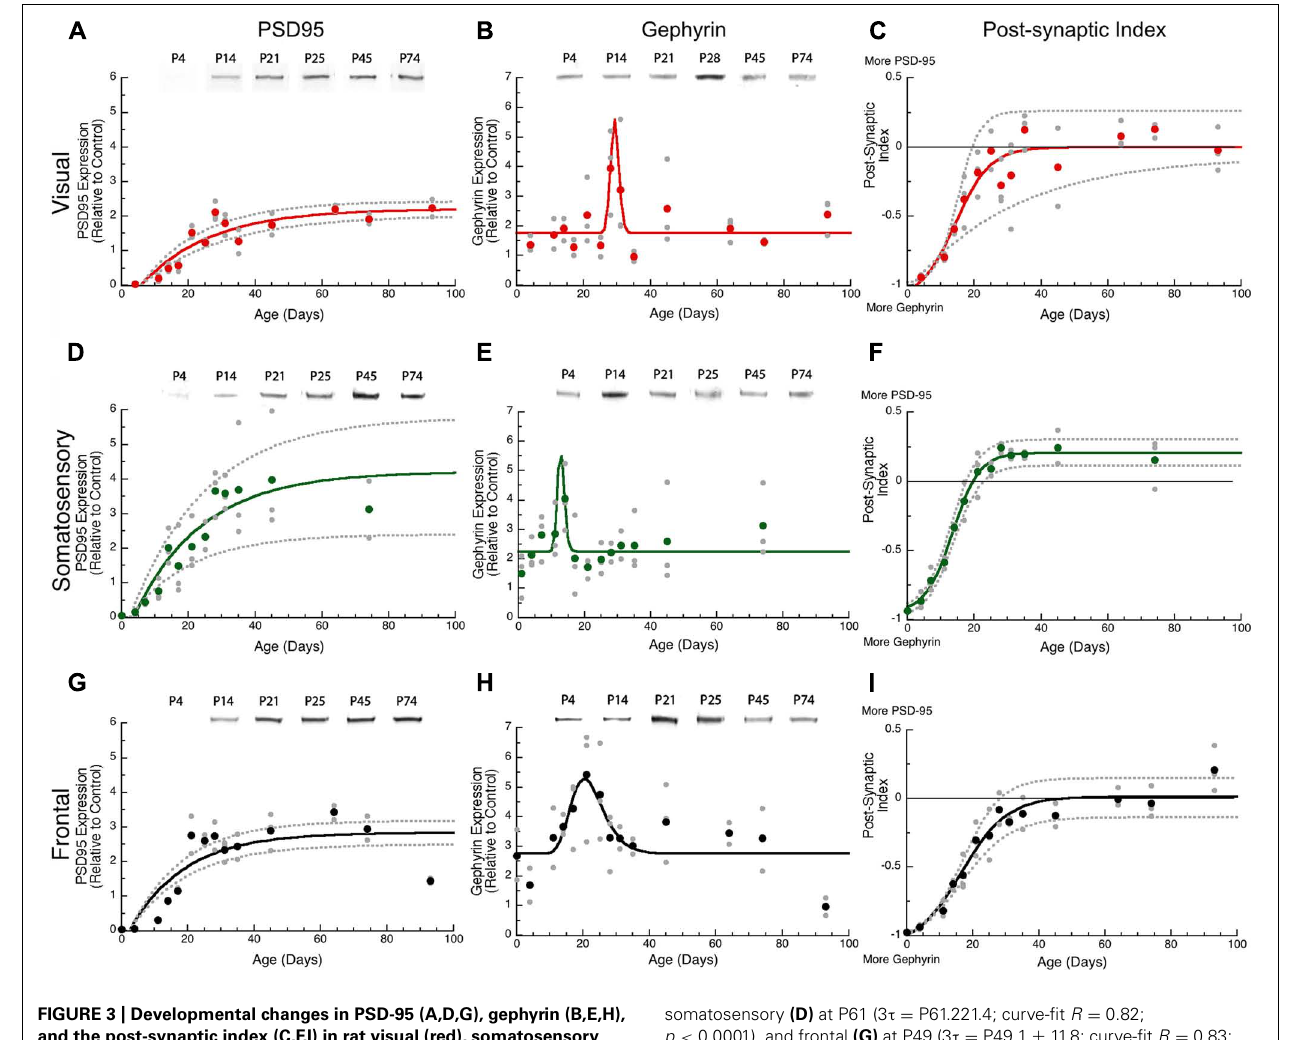
FIGURE 3 | Developmental changes in PSD-95 (A,D,G), gephyrin (B,E,H), and the post-synaptic index (C,F,I) in rat visual (red), somatosensory (green) and frontal (black) cortex. Gray dots are results from all runs, and color dots are the average for each. Example bands for each protein and area are shown above the graphs. An exponential decay function was fit (solid line) to PSD-95, a sigmoid function (solid line) was fit to the post-synaptic index, and 95% confidence intervals (dotted lines) were added. Adult levels are defined as 3 τ , or the age when 87.5% of the asymptotic expression level was reached. Peak function was fit to gephyrin expression. PSD-95 reached adult levels in visual (A) at P62 (3 τ = 61.9 ± 12.3; curve-fit R = 0.89; p < 0.0001),